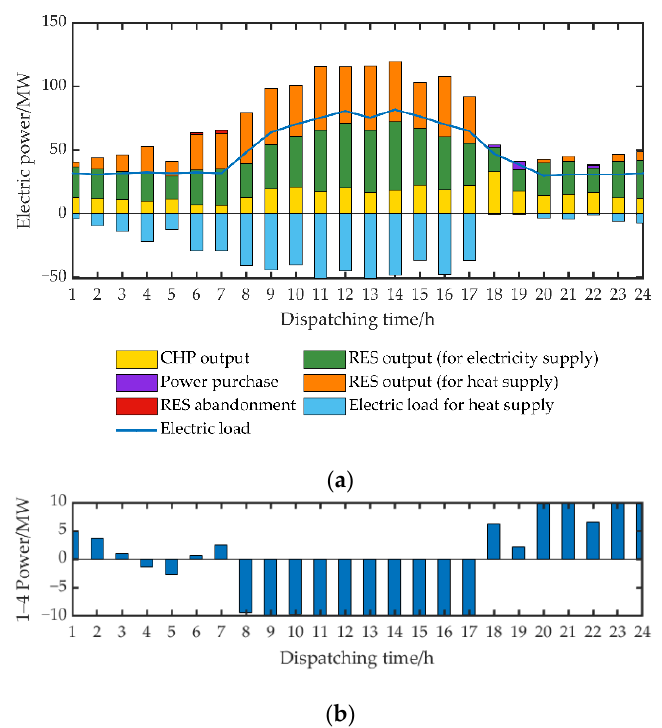
Figure 14. Dispatching strategy of the industrial area under joint dispatching: ( a ) Electric power of the industrial area; ( b ) Electric power of the tie line.